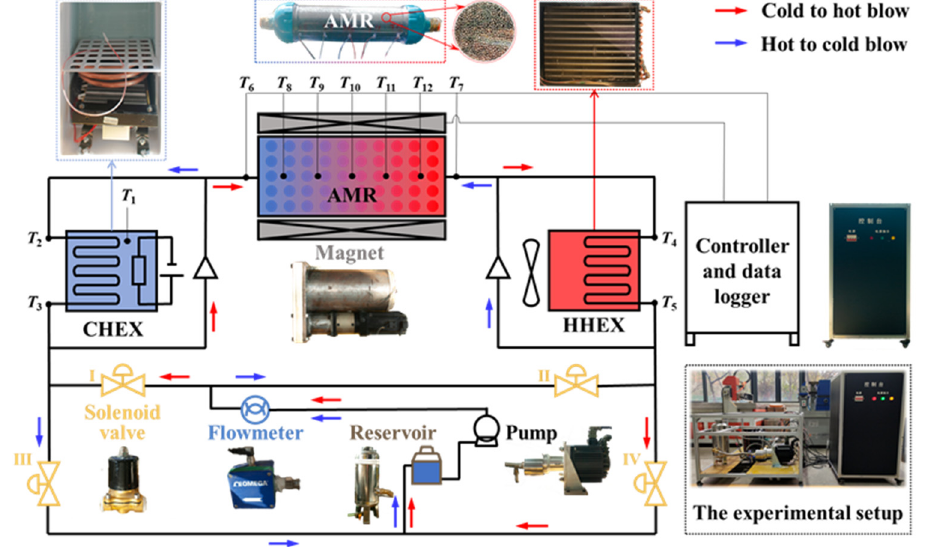
Figure 3. Experimental apparatus.